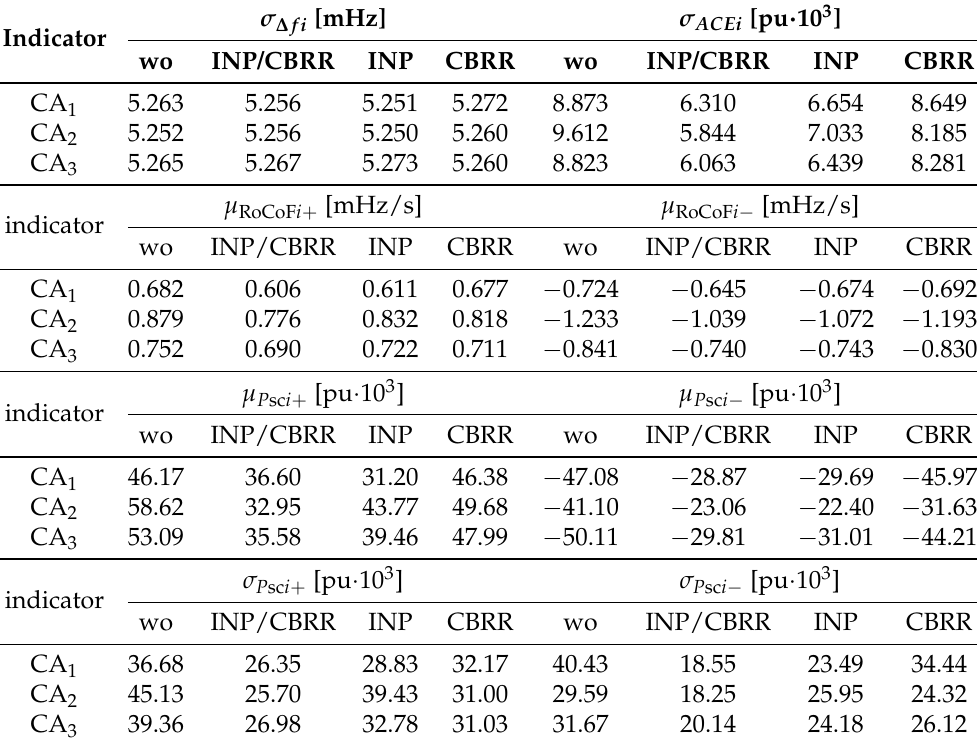
Table 3. Performance indicators, RoCoF, mean value, and standard deviation of